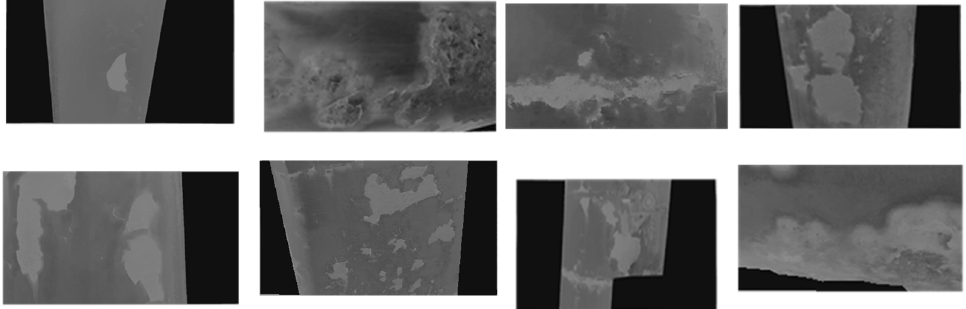
Figure 9. The corroded region in the Cb component of YCbCr color space in representative imag- es.